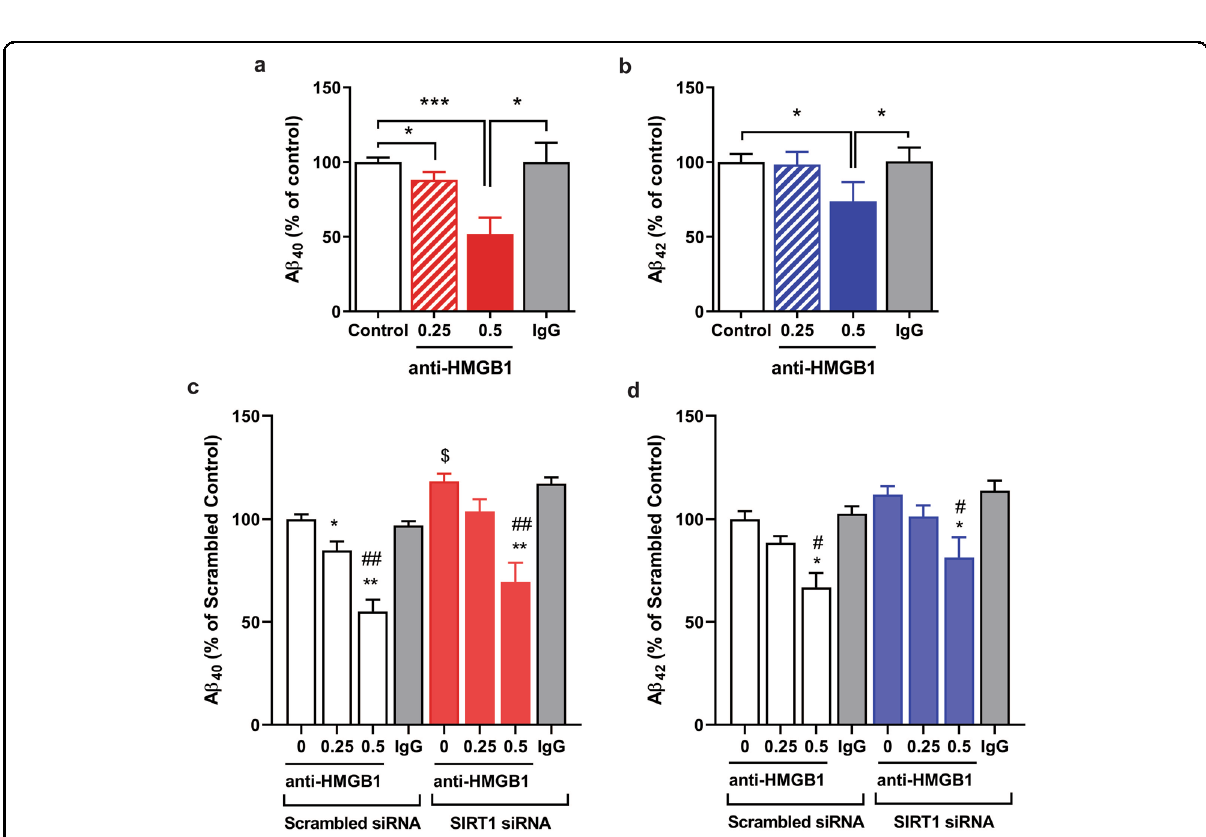
Fig. 6 Effects of anti-HMGB1 neutralizing antibody on the levels of extracellular A β released from H4swe cells treated with H/R- conditioned medium (CM) from HBMVECs. HBMVECs were exposed to H/R for 1 h and reoxygenated for 24 h, and CM collected. This was treated with anti-HMGB1 antibody (0.25 or 0.5 μ g/ml), and then H4swe cells were cultured with H/R CM with or without neutralization for 24 h. The concentrations of A β 40 ( a ) and A β 42 ( b ) in CM were analysed by ELISA. Data are presented as the mean ± SD from repeated independent experiments ( n = 3 – 4). * p < 0.05, *** p < 0.001 by unpaired t -tests. HBMVECs with or without Sirt1 silencing were exposed to 24-h H/R, and then H4swe cells were treated with the endothelial CM with or without neutralization of HMGB1. The levels of A β 40 ( c ) and A β 42 ( d ) in H4swe CM were analysed by ELISA. Data are presented as mean ± SD from repeated independent experiments ( n = 3 – 4). * p < 0.05, ** p < 0.01 versus vehicle control ; # p < 0.05, ## p < 0.01 versus IgG, $ p < 0.05 versus the control scrambled siRNA group by unpaired t